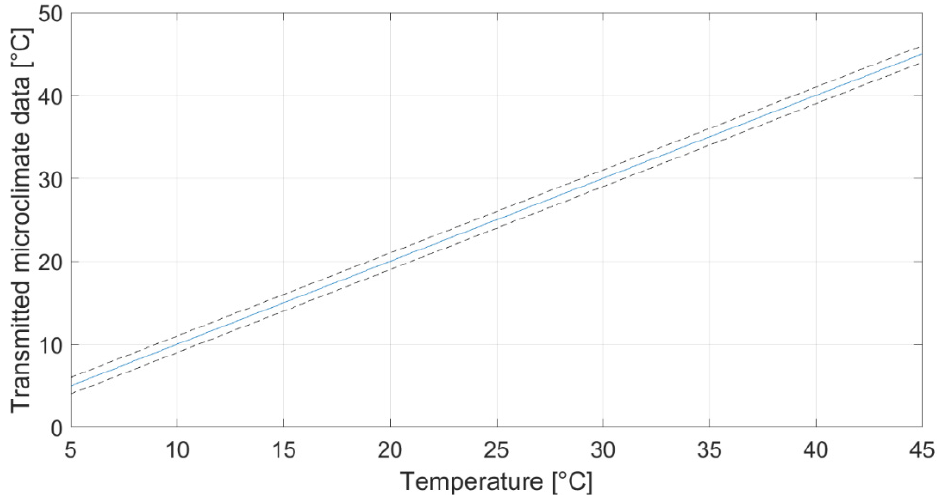
Figure 6. Characterization in terms of temperature at 50% of relative humidity.